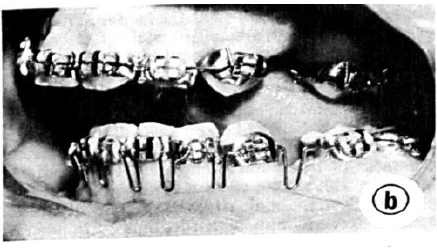
Figure 2: Canine retraction using full archwire with bonding the incisors for their